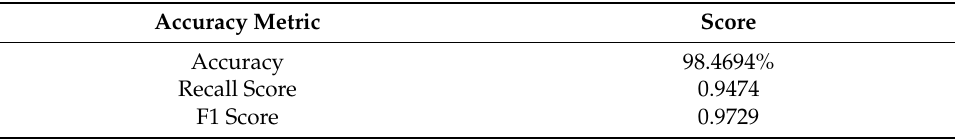
Figure 14. ( a ) Training loss curve, ( b ) validation loss curve, and ( c ) confusion matrix of validation data. Table 2. Accuracy metric readings of Table 2. Accuracy metric readings of VGG-16.